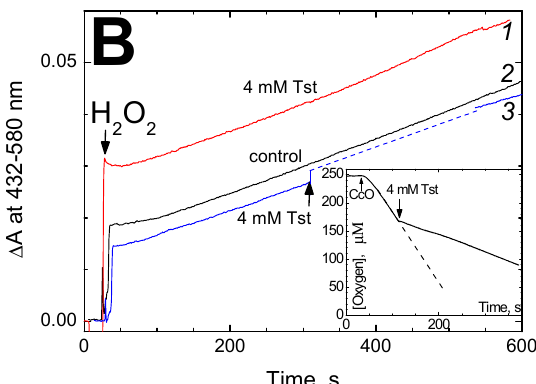
Figure 5. E ff ect of steroid hormones on the peroxidase activity of CcO. ( A ) E ff ect of estradiol. Peroxidation of o -dianisidine was monitored by increase of absorption at 432 nm vs. 580 nm as a reference. The basic reaction medium (pH 7.6) with 1 mM DM contained 0.2 mM o -dianisidine and 0.6 µ M CcO. The reaction was initiated by addition of 4 mM H 2 O 2 . Trace 1 (red)—recording in the presence of 0.5 mM estradiol benzoate, trace 2 (black)—the control. The initial jump upon H 2 O 2 addition corresponds to spectral response of heme a 3 in CcO. Inset: 0.5 mM estradiol in the presence of 1 mM DM does inhibit cytochrome oxidase activity of CcO (see Figure 1A for more details). ( B ) E ff ect of testosterone (Tst). The conditions are as in panel A except that concentration of DM in the bu ff er was 20 mM. Trace 1 (red)—recording in the presence of 4 mM testosterone, trace 2 (black)—the control, trace 3 (blue)—testosterone (4 mM) was added during the reaction time course (indicated by the arrow), which was followed by temporary increase of turbidity (the supposed trajectory until spectral registration became possible is shown by the dashed line). Inset: 4 mM testosterone in the presence of 20 mM DM does inhibit oxidase activity of CcO (see Figure 2A for other